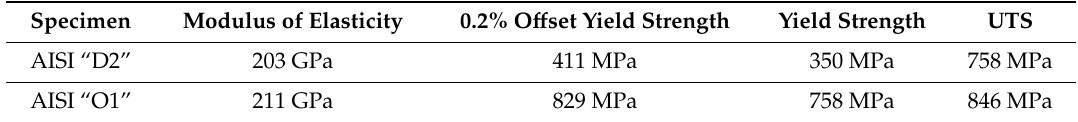
Table 4. Experimental tensile tests data summary of "D2" and "O1" tool